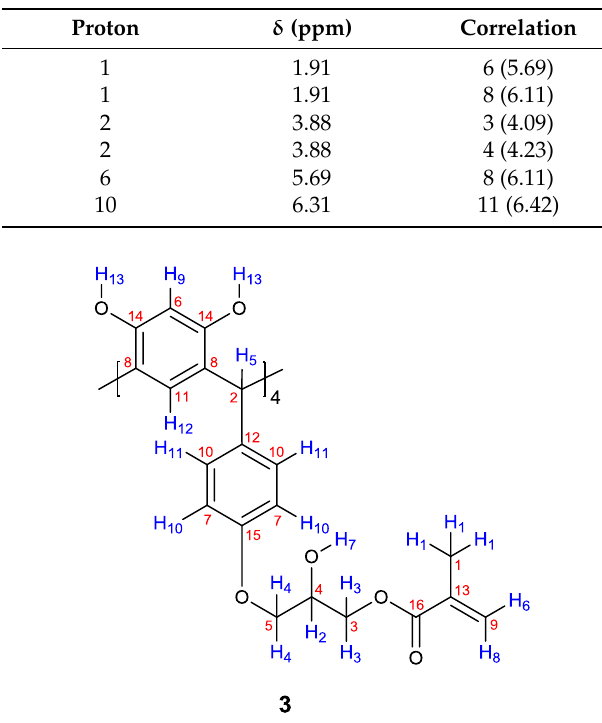
Table 1. Principal correlations for compound 3 in the COSY spectrum.